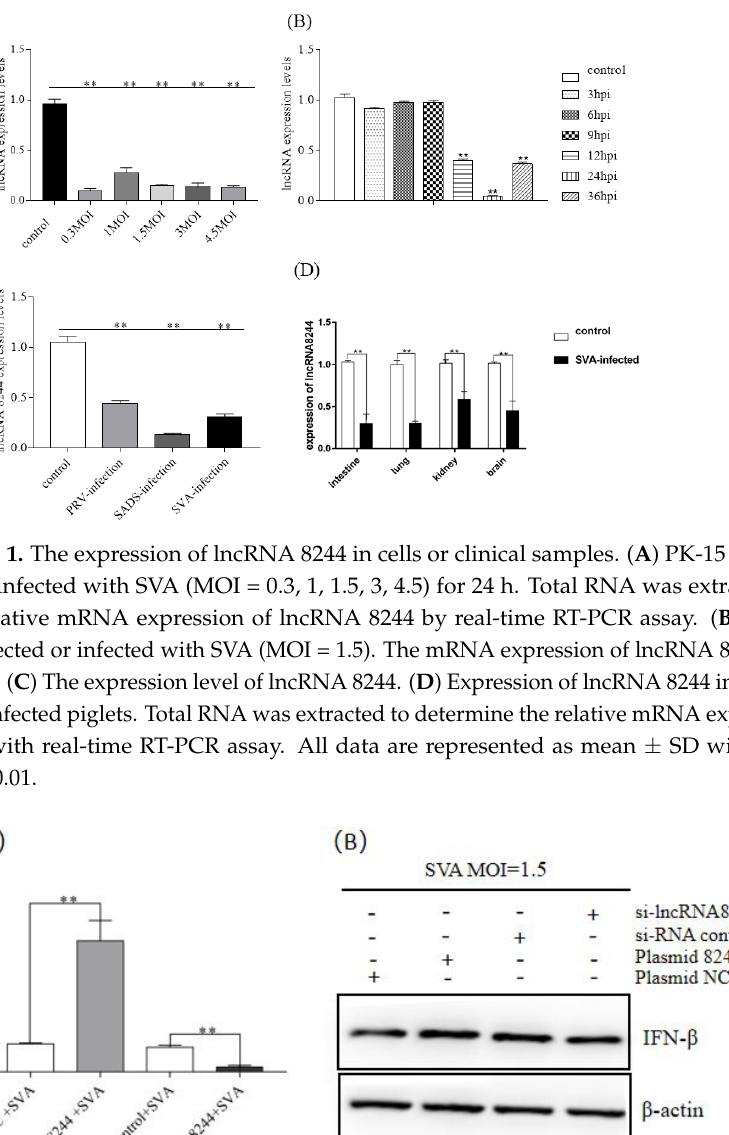
Figure 2. LncRNA 8244 can promote the expression of IFN- β . ( A ) PK-15 cells were treated with plasmid NC/plasmid 8244/iNC/si-lncRNA 8244 for 24 h, and then infected with SVA (MOI = 1.5) for an additional 24 h. The expression level of IFN- β was determined by real-time RT-PCR or Western blot ( B ). The mRNA level of IFN- β was normalized to the mRNA level of GAPDH, and anti- β actin was used as a control for Western blot sample loading. All data are represented as mean ± SD with three replicates. ** p <